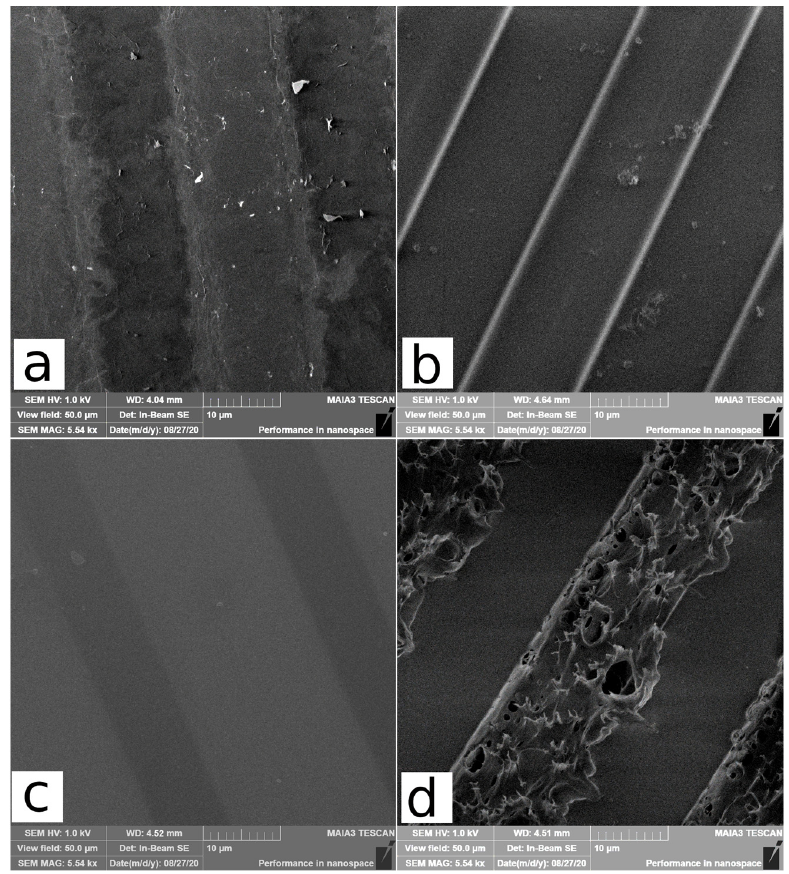
Figure 4. The SEM images of the structures prepared using ion-beam writing on surfaces of GO ( a ), PET ( b ), PI ( c ), and PMMA ( d ). These samples were irradiated with a fluence 5.625 × 10 14 cm − 2 .